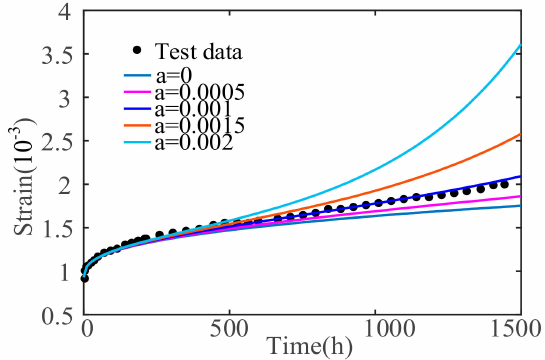
Figure 9. Sensitivity analysis under di ff erent material parameters α